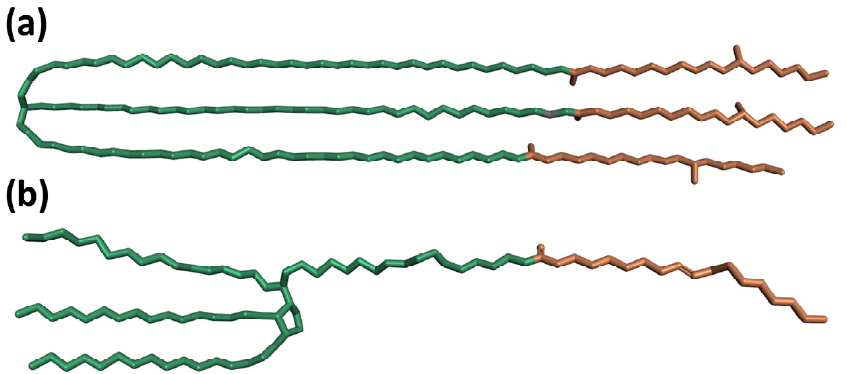
Figure 9. The average R g values of different systems without cosolvents (red column) and containing cosolvents (black column) during the last 30 ns simulation time. Error bars are plotted as ± SD. The symbol “***” represents statistical significance with p < 0.001.